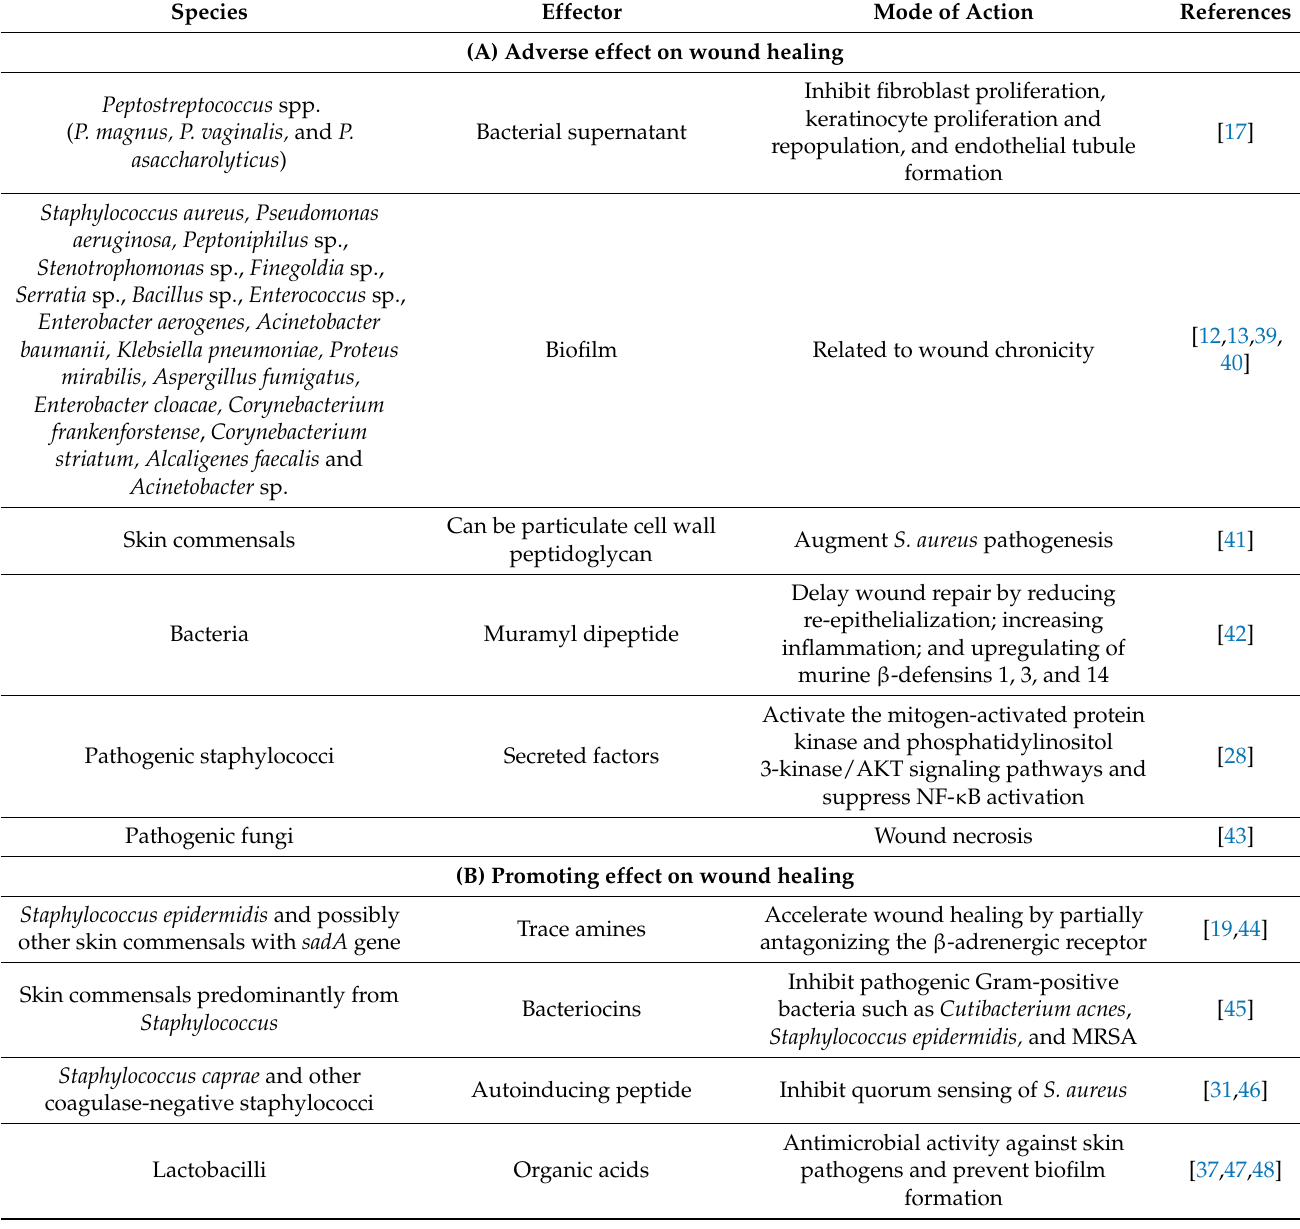
Table 1. Microbiota species that have an adverse (A) or a promoting (B) effect on wound healing.